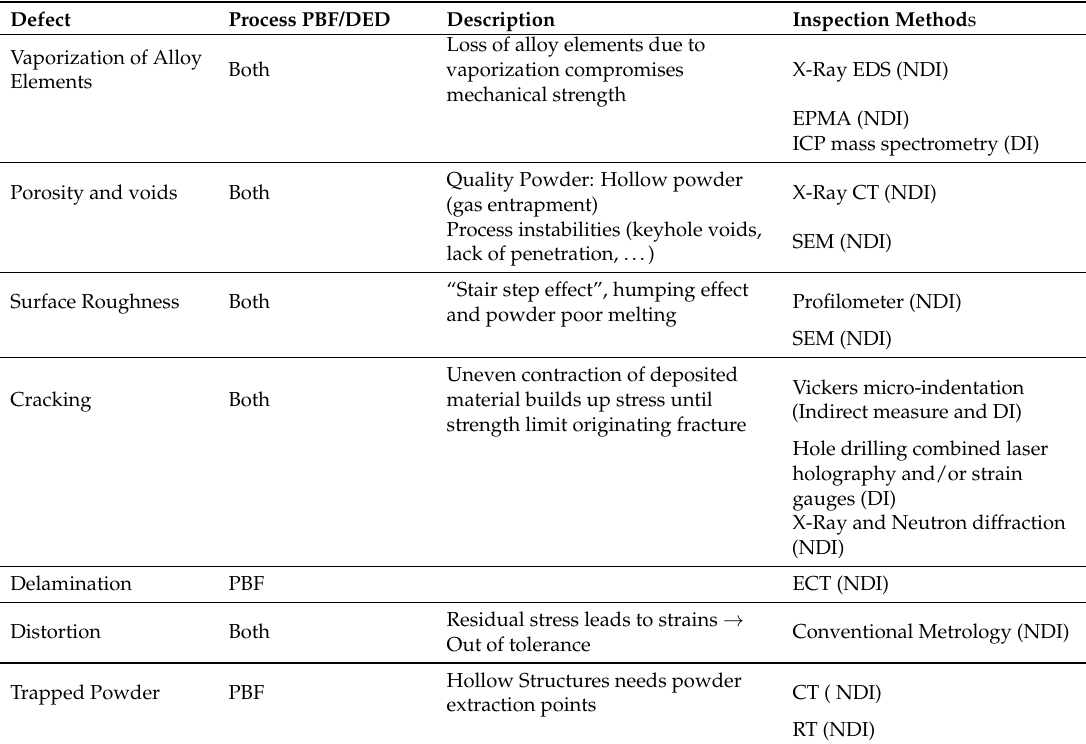
Table 4. AM common defects and its inspection methods